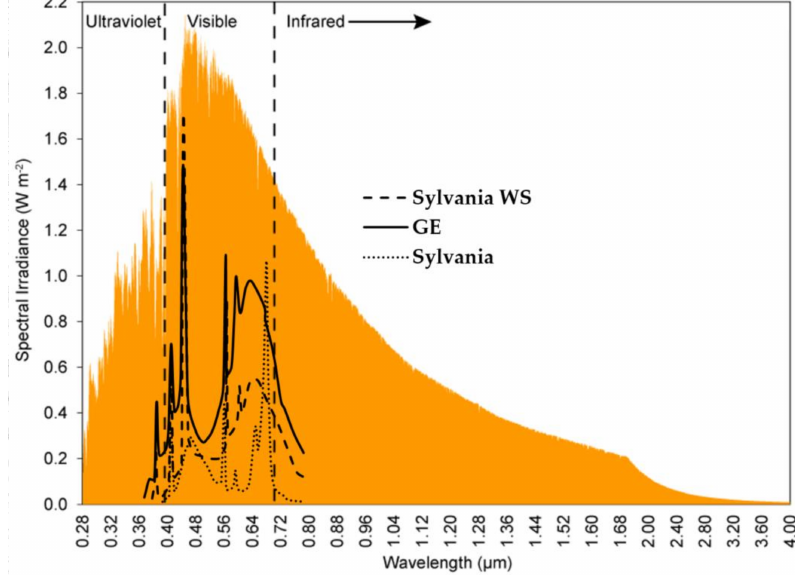
Figure 1. Light spectrum of solar light (orange colored area) [44] and light sources used in the study (Sylvania WS (—): F12T20/Gro/AQ/WS, GE ( ___ ): GE PL/AQ F12T20, and Sylvania ( ... . ): Gro-lux